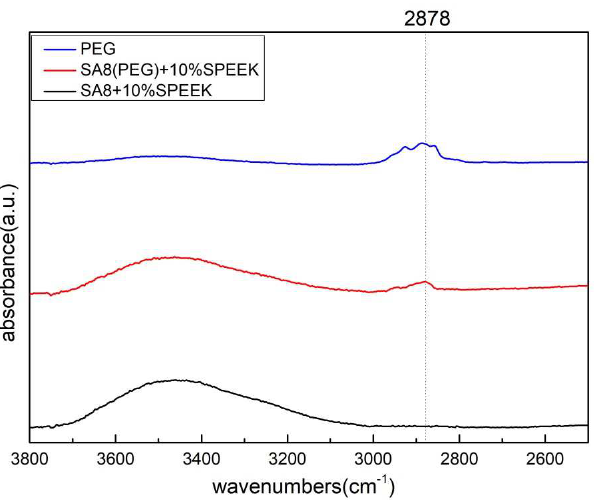
Figure 10. FT-IR spectra of SA8(PEG) + sPEEK blended series at 3800–2500 cm −1 .